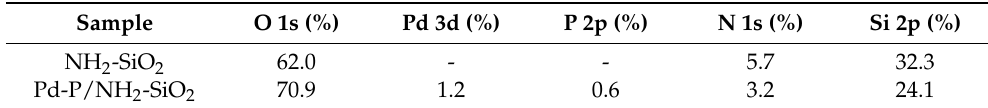
Table 4. XPS atomic percentage of the